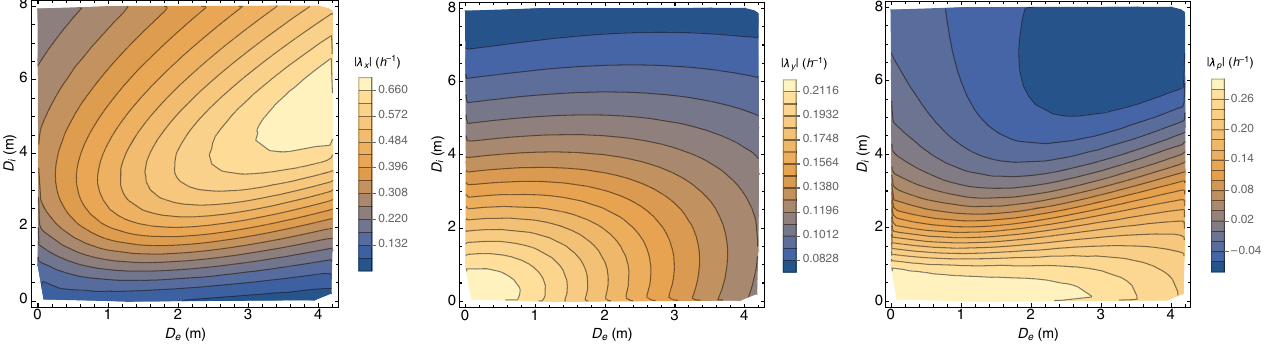
FIG. 9. Dependence of the cooling rate on dispersions.